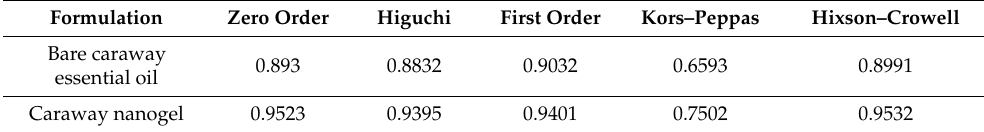
Table 1. Kinetic model for bare caraway essential oil and caraway nanogel after dissolution study.